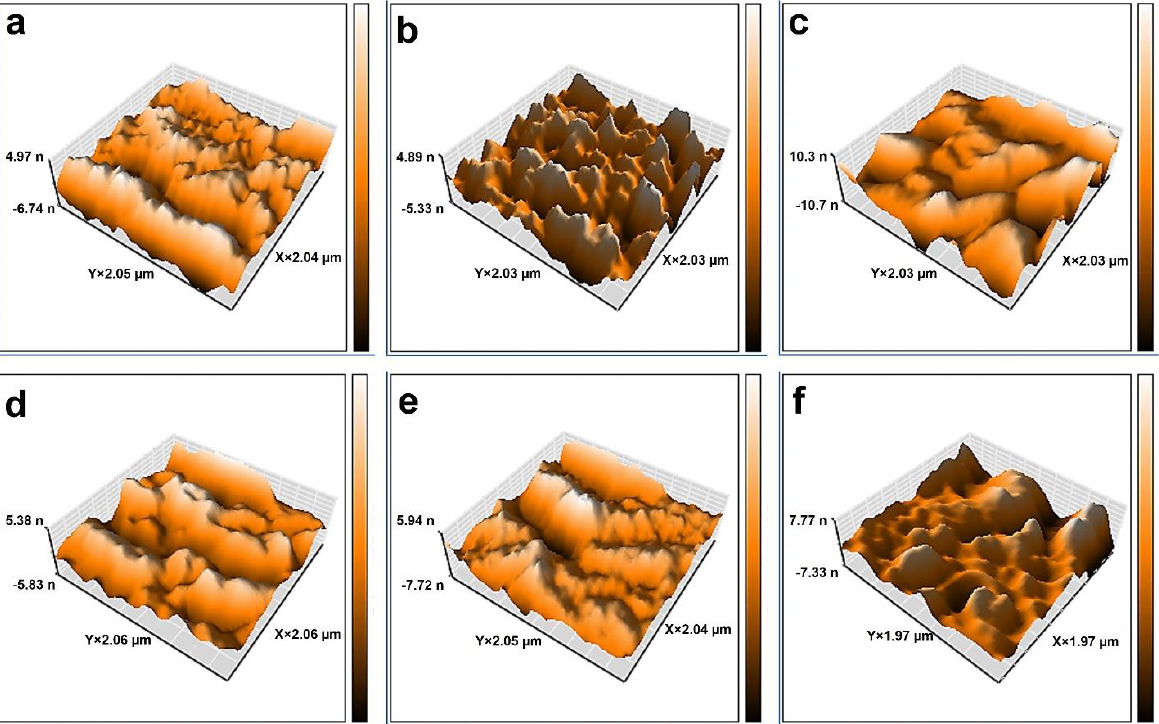
Figure 4. AFM topographical illustrations of various membranes: ( a ) M0, ( b ) M1, ( c ) M2, ( d ) M3, ( e ) M4, and ( f ) M5. Table 1. Surface roughness, contact angle, porosity, and mean pore size of the prepared membranes.